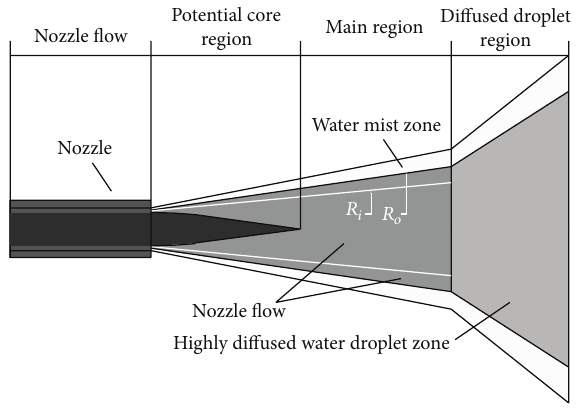
Figure 2: Jet structure based on theory and observation [6].